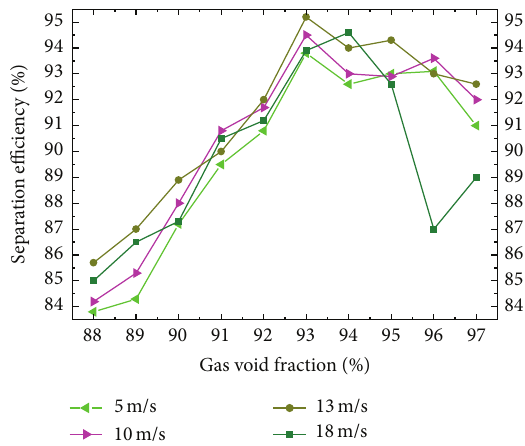
Figure 5: The influence of gas void fraction on the separation efficiency under different inlet velocities.